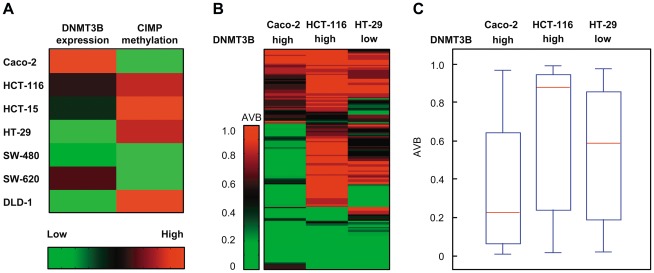
Endogenous level of DNMT3B protein expression does not correlate with CIMP status.(A) Comparison of DNMT3B expression and CIMP status. Red color indicates high levels of DNMT3B protein expression and high levels of CIMP marker methylation, green color indicates low levels of DNMT3B expression and low levels of CIMP marker methylation, respectively. Protein expression levels were derived from immunoblot analysis (Figure 1C) and methylation levels of the five CIMP marker genes CACNA1G, IGF2, NEUROG1, RUNX3, and SOCS1 in the cell lines were derived from [25]. (B) Heatmap of CG methylation at 174 loci representing 67 CIMP marker genes [25] in Caco-2, HCT-116, and HT-29 colon cancer cell lines. Average methylation was analyzed using Infinium 27 k methylation arrays. (C) Boxplots illustrate methylation levels of CIMP markers in Caco-2, HCT-116, and HT-29 cell lines. Lines in boxes denote medians, boxes the interquartile range, and whiskers the 2.5th and 97.5th percentiles, respectively. AVB, Average Beta value.